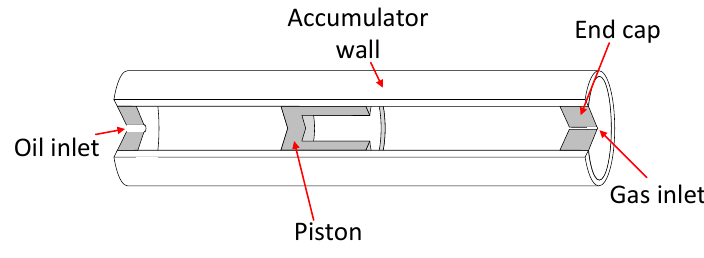
Figure 2. Schematic of the accumulator showing internal